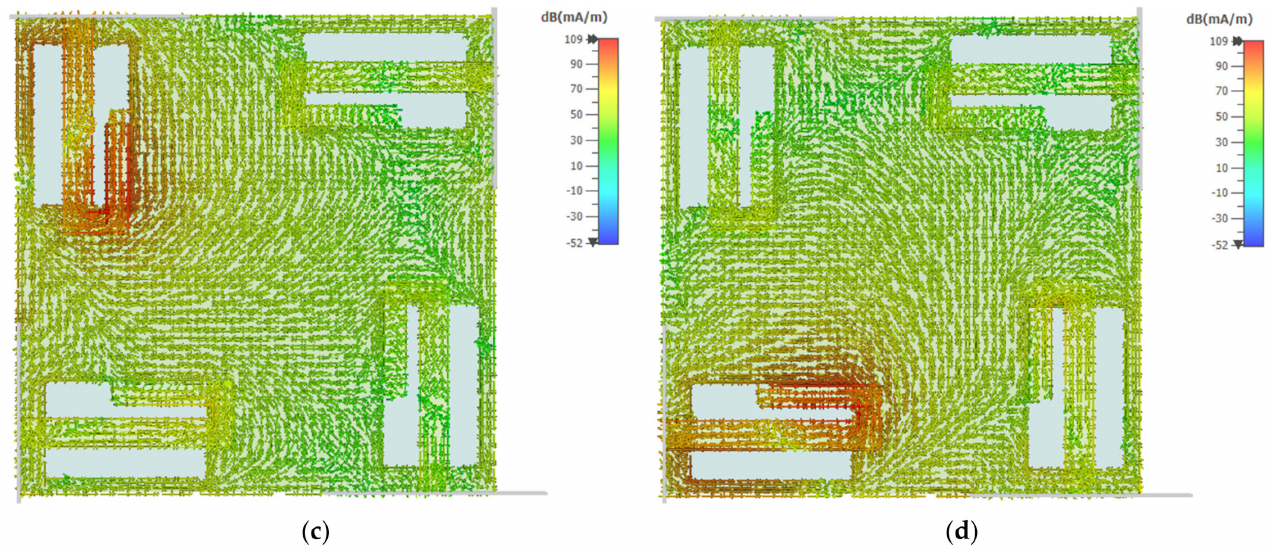
Figure 7. Surface currents at 4.8 GHz: ( a ) Ant 1, ( b ) Ant 2, ( c ) Ant 3, ( d ) Ant 4.